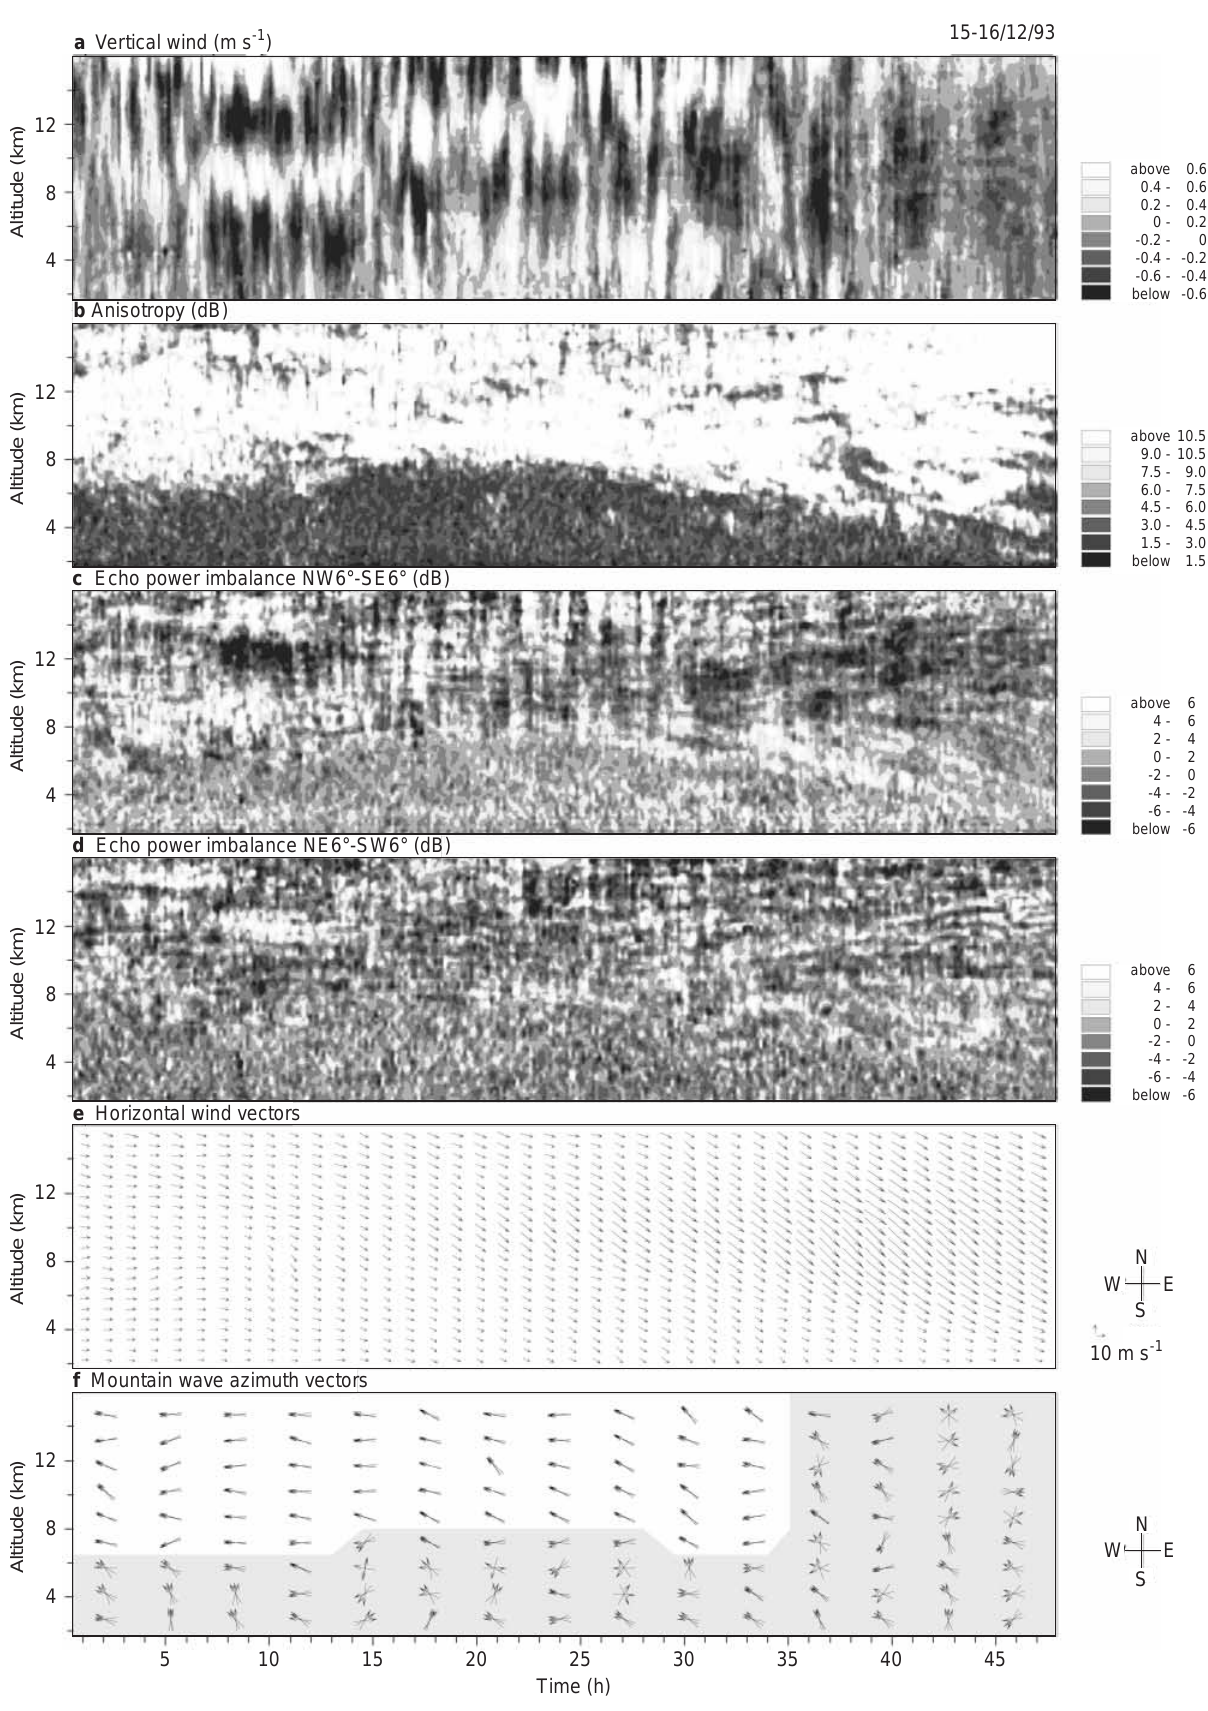
Fig. 7a–f. As Fig. 4, for 15–16 December